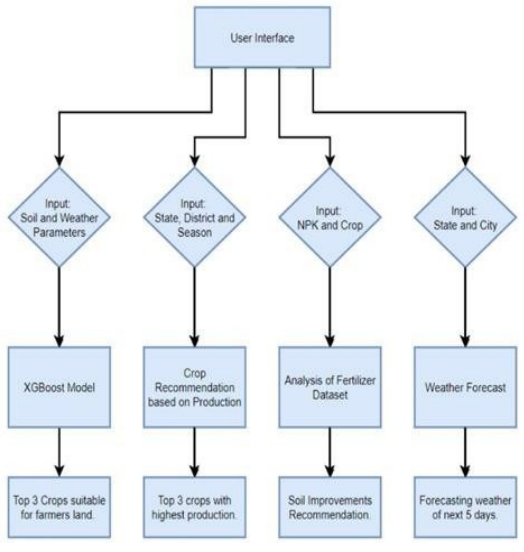
Figure 3.1 Crop Recommendation